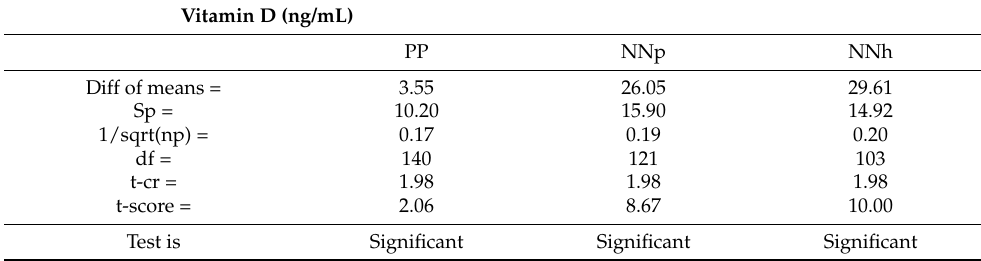
Table 2. The Student’s t -test for differences of the vitamin D mean values in PP vs. NNp, PP vs. NNh, and PP vs. NNh groups; the differences of the mean levels of vitamin D in all three groups are statistically significant.